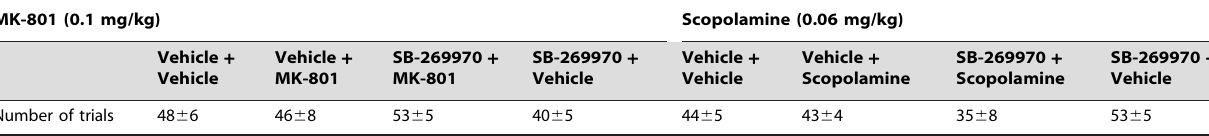
MK-801 (0.1 mg/kg)